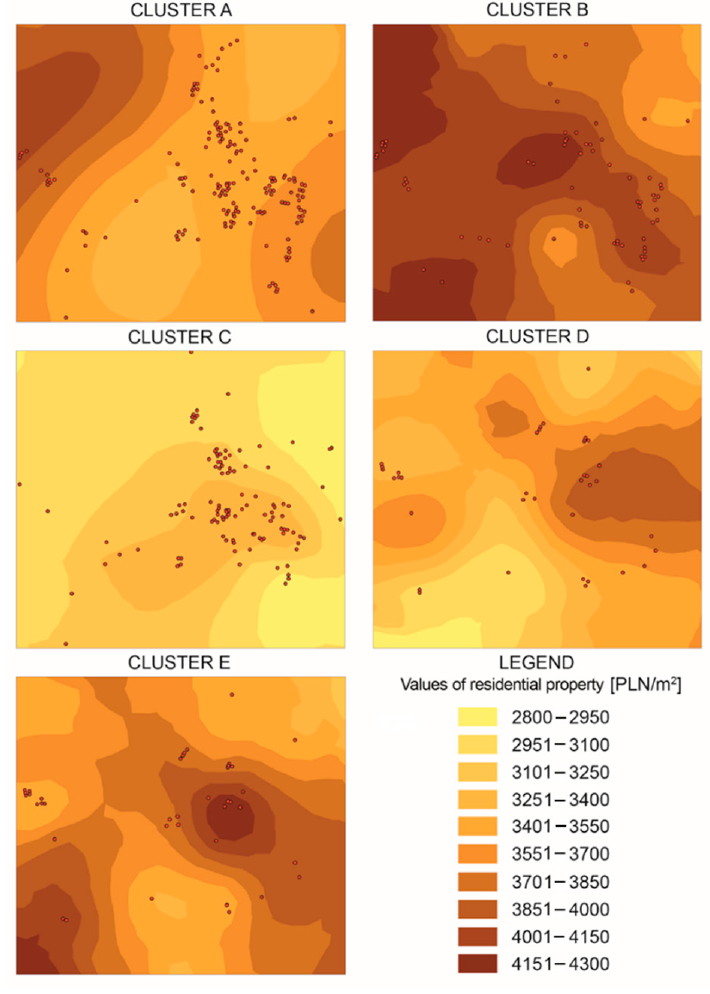
Figure 3. Kriging interpolation of residential property values.